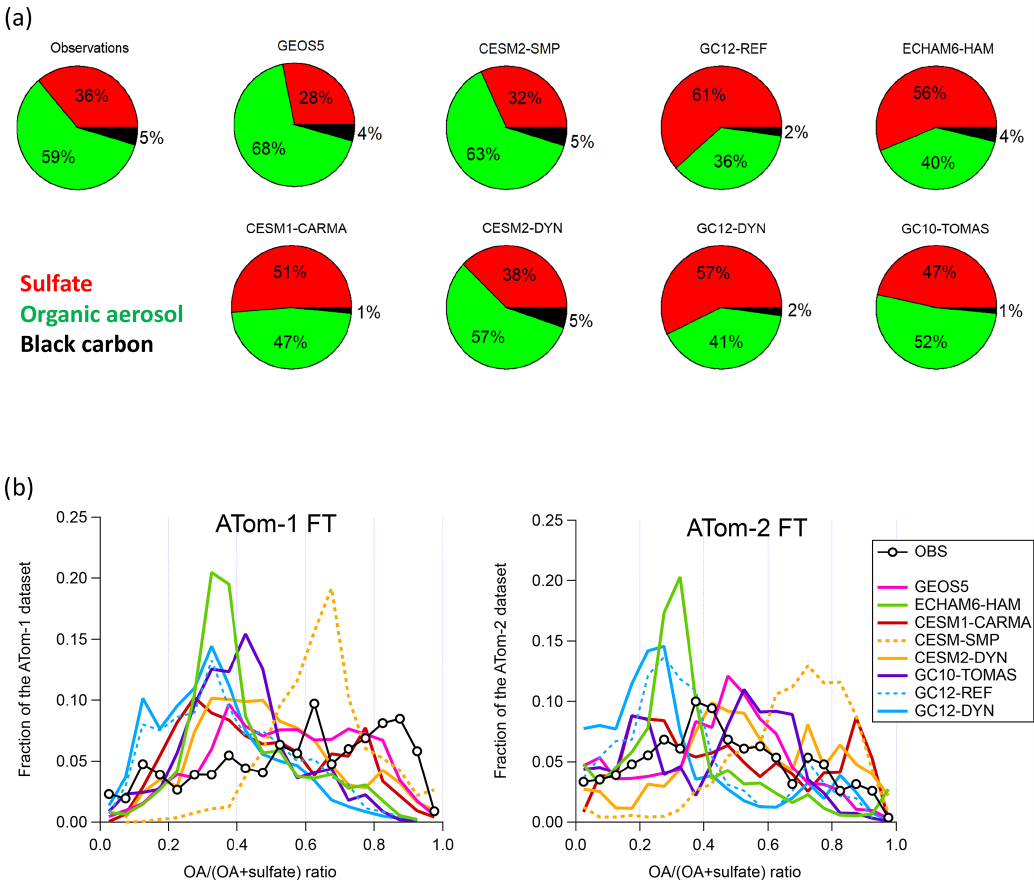
Figure 9. (a) Predicted and measured composition of submicron aerosols in the free troposphere as a function of the submicron aerosol mass concentrations during ATom-1. (b) Frequency distribution of the observed and simulated ratio of organic to organic plus sulfate aerosols in the free troposphere during ATom-1 and